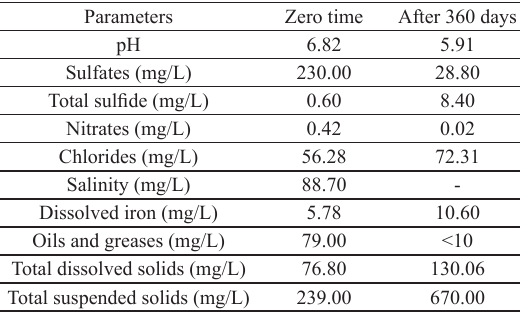
Table 4. Physicalchemical analysis of the produced